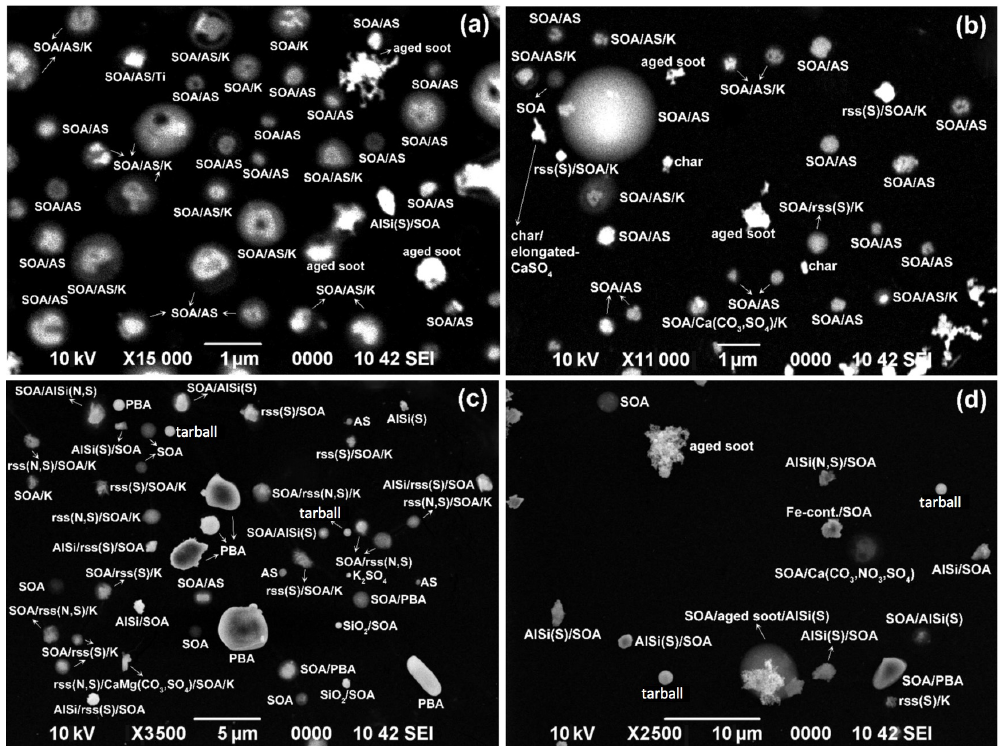
Figure 5. Typical SEM images of aerosol particles for (a) stage 1 (PM 0 . 25 − 0 . 5 ) of the SM1 sample, (b) stage 2 (PM 0 . 5 − 1 . 0 ) of the SM2 sam- ple, (c) stage 3 (PM 1 − 2 ) of the SM1 sample, and (d) stage 4 (PM 2 . 0 − 4 . 0 ) of the SM3 sample, collected at the Manaus site. For convenience, ammonium sulfate, secondary organic aerosol, aluminosilicates, and reacted sea salt are denoted as “AS”, “SOA”, “AlSi”, and “rss”, respec-